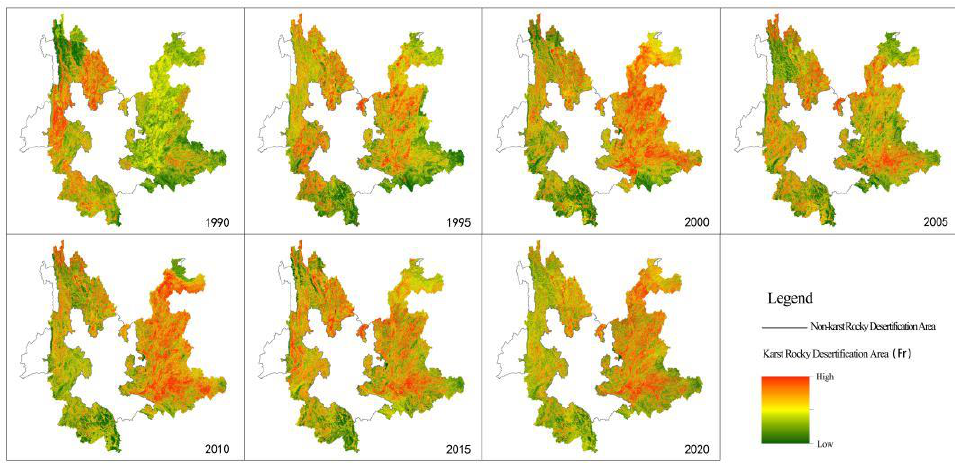
Figure 5. Dynamic evolution characteristics of Fr in Yunnan karst rocky desertification areas (1990 – 2020).